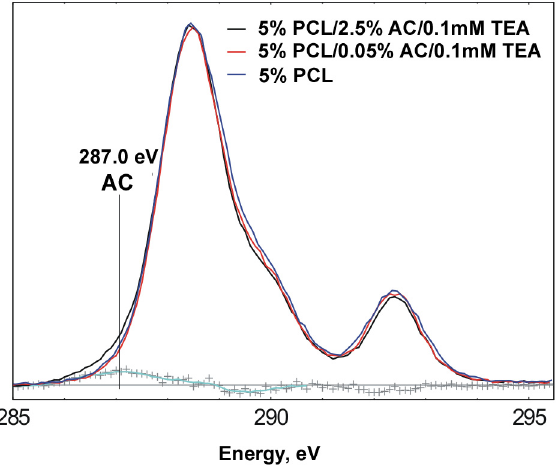
Figure 4. Comparison of high-resolution C1s spectra for PCL-based scaffolds: 5% PCL, 5% PCL/0.05% AC/0.1mMTEA, 5% PCL/2.5% AC/0.1mMTEA. Cyanide curve (marked as +++) corresponding to the difference spectrum between the curves for samples 5% PCL/0.05% AC/0.1mMTEA and 5% PCL/2.5% AC/0.1mMTEA.